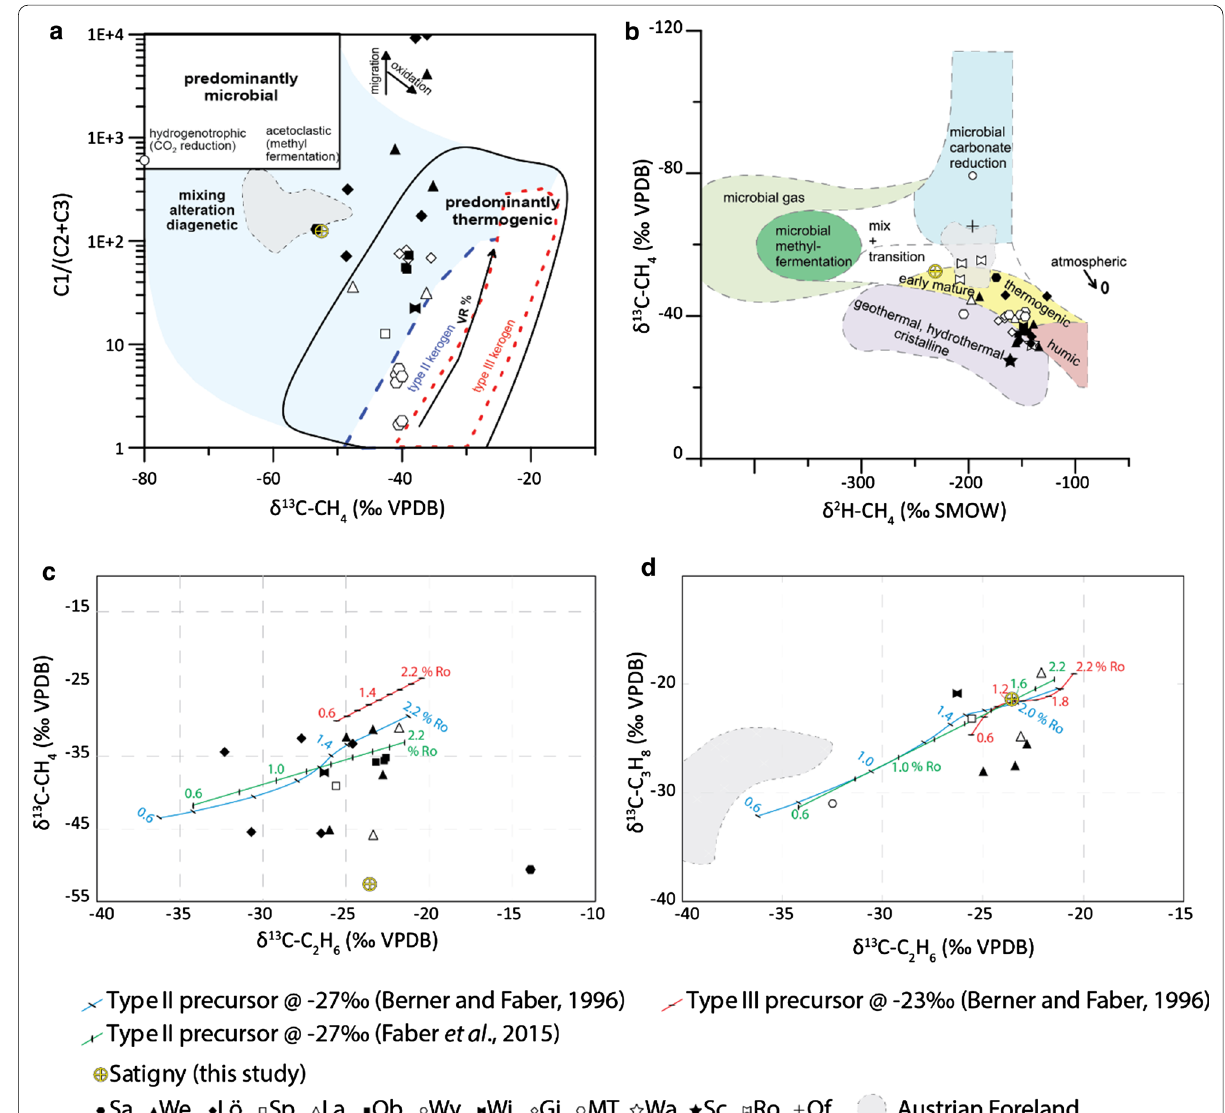
Fig. 9 a Modified “Bernard diagram” showing the methane carbon isotopic composition vs. dryness (modified after Bernard et al. 1978; Whiticar 1999) showing the composite biogenic and thermogenic composition of the gas retrieved from Satigny (this study). b Interpretation of gas origin using stable carbon and hydrogen isotopic composition of methane according to Whiticar (1999). c Stable carbon isotopic composition of methane and ethane from the Satigny gas sample. d Stable carbon isotopic composition of ethane and propane from the Satigny gas sample. The vitrinite reflectance ⁄ isotope composition lines (maturation lines) are obtained using the calibration data for Type II and III source rocks from Berner and Faber, (1996) and Type II source rock from Faber et al. (2015). Samples Sa (Sachseln), We (Wellenberg), Lö (Lötschberg), Sp (Spiez), La (Langenthal), Ob (Oberbauenstock), Wy (Wynau), Wi (Wilen), Gi (Giswil), MT (Mont Terri), Wa (Weiach), Sc (Schafisheim), Ro (Rothrist and Lättweg), Of (Oftringen) are synthesized from the Swiss Plateau (Wyss 2001; Etiope et al. 2010; Eichinger et al. 2011; Sachs and Schneider 2012). Dashed grey area show the geochemistry of gas samples from the Austrian Molasse Basin (Pytlak et al.